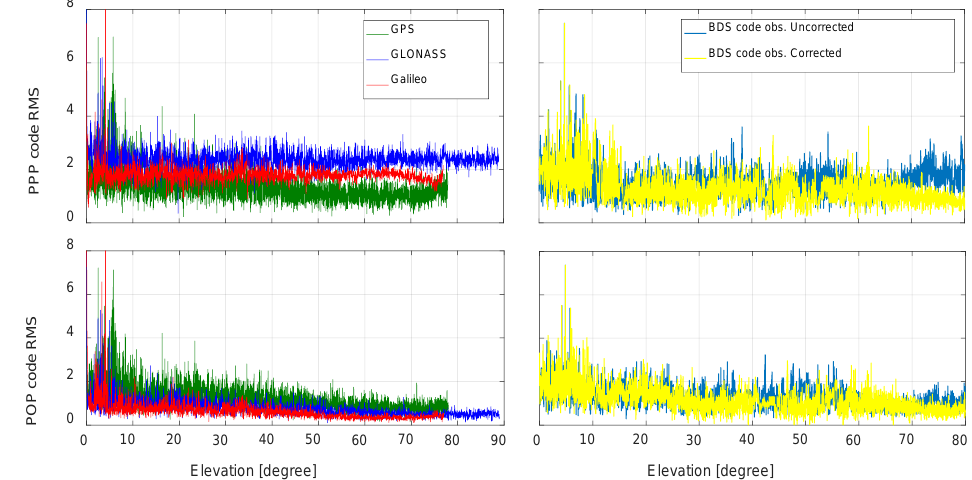
Figure 1. The RMS values of IF code residuals of PPP and POP solutions. For each system, the code residuals of all involved satellites are lumped together to calculate the RMS values. The Beidou code observations before and after corrected with the satellite-induced code bias are shown in the right two subplots.